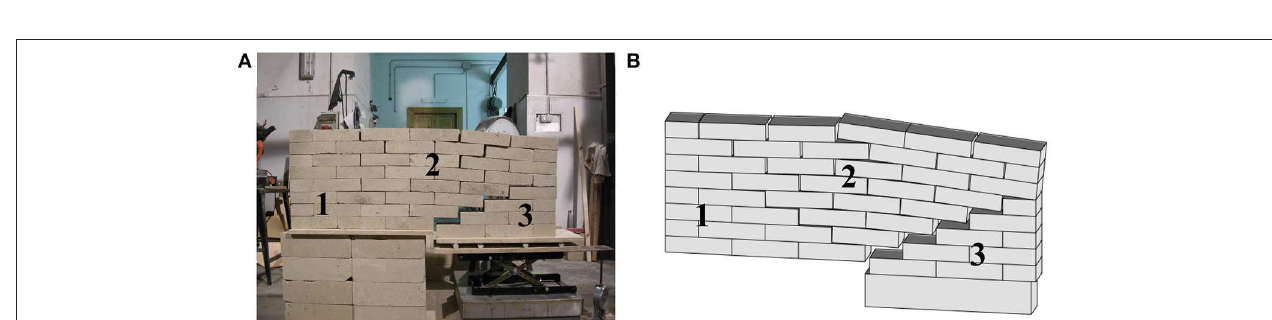
FIGURE 3 | Modified Mohr-Coulomb criterion.